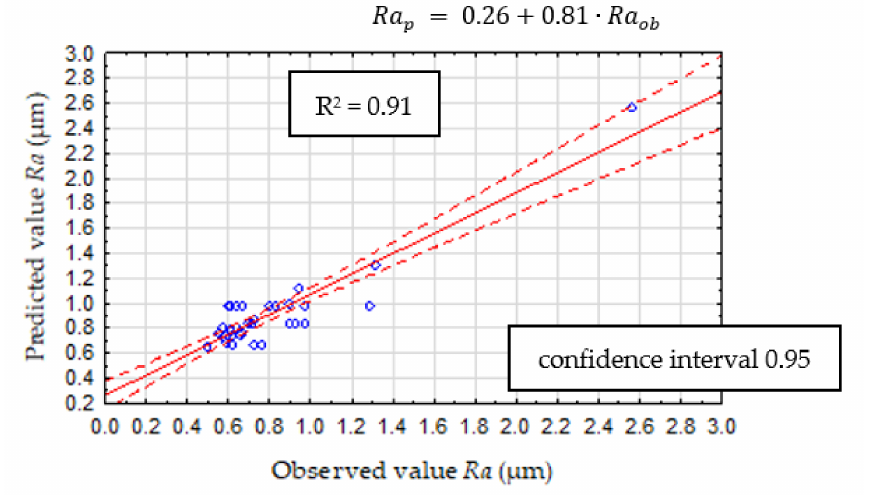
Figure 15. CART validation